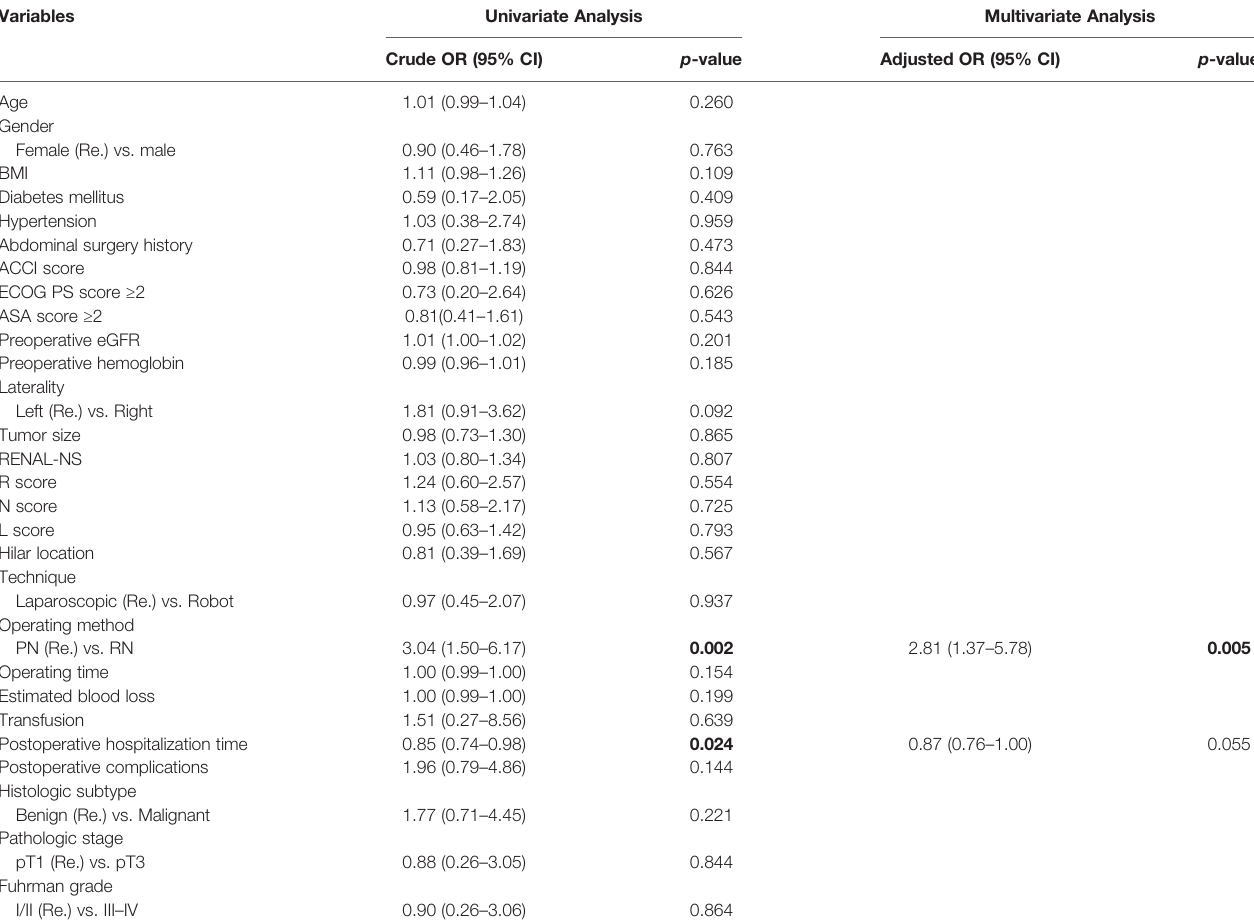
TABLE 4 | Univariate and multivariate Logistic analysis of independent risk factors for 48-h postoperative AKI.